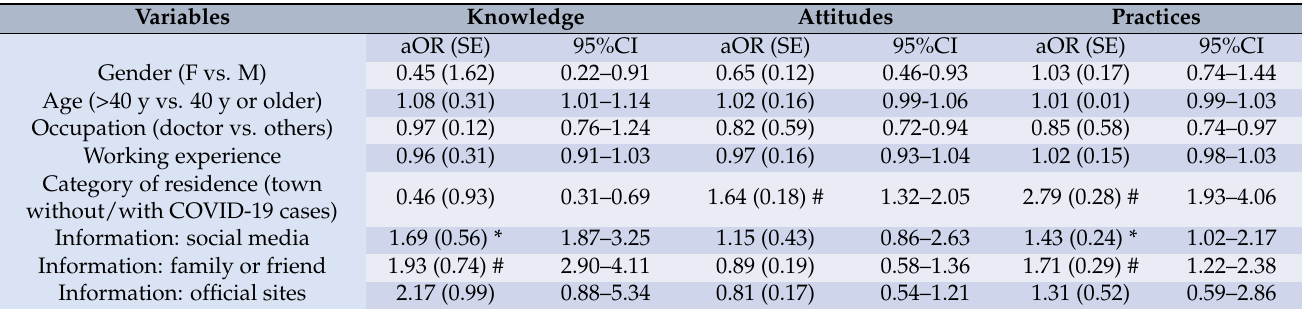
Table 3. Determinants of knowledge, attitudes, and practices (KAPs) in HCWs according to multivariate logistic regression